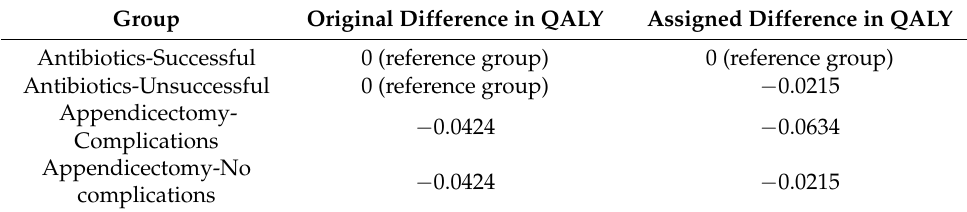
Table 2. Sensitivity analysis 2. Group Original Difference in QALY Assigned Difference in QALY Antibiotics-Successful 0 (reference